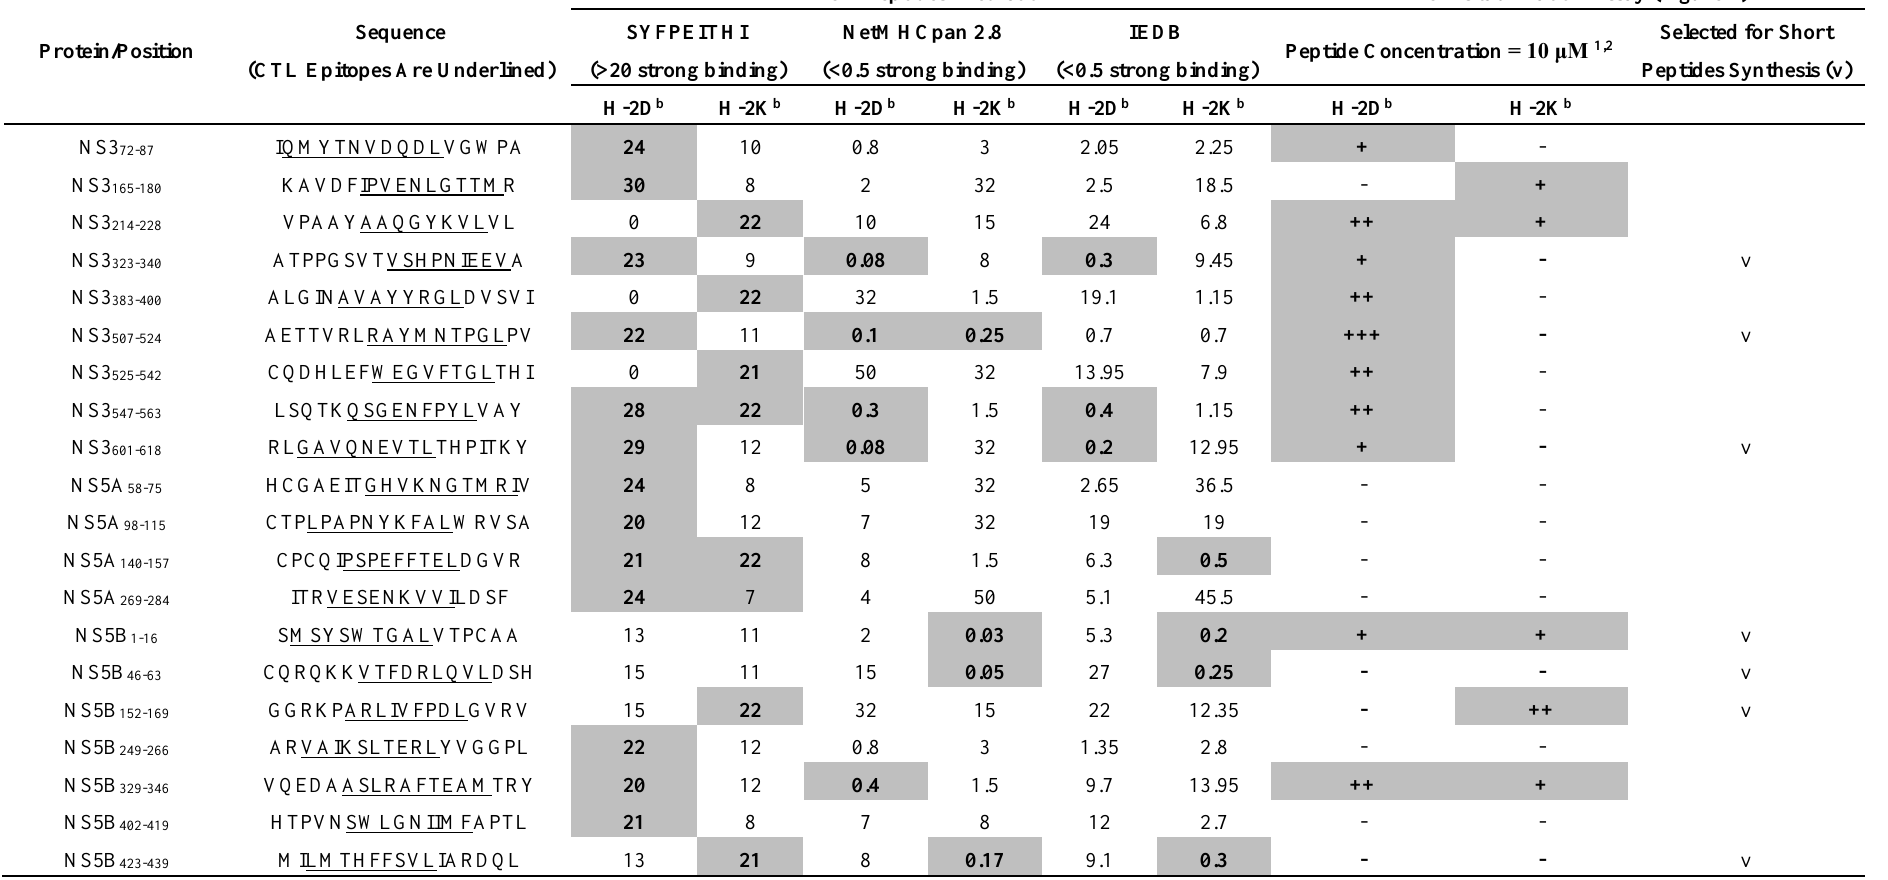
Table 1. Selection of synthetic long peptides containing CTL epitopes from HCV nsPs by prediction algorithms. Sequences of the long synthetic peptides, for which MHC binding affinity was shown in Figure 1, are shown. Strong binders are depicted in bold and highlighted in grey. The cut off score of SYFPEITHI is set at 20; a high score indicates a strong binder. The cut off score of NetMHCpan 2.8 and IEDB is set at 0.5 (% rank); a low score indicates a strong